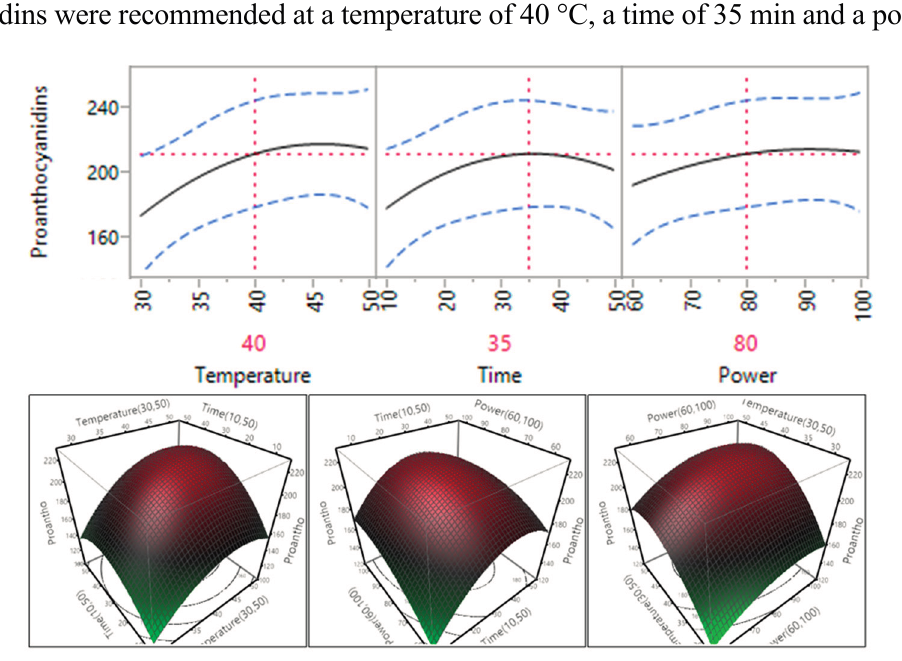
Figure 6. Impact of temperature (60–90 °C), time (10–30 min) and power (60%–100%) on proanthocyanidins (mg